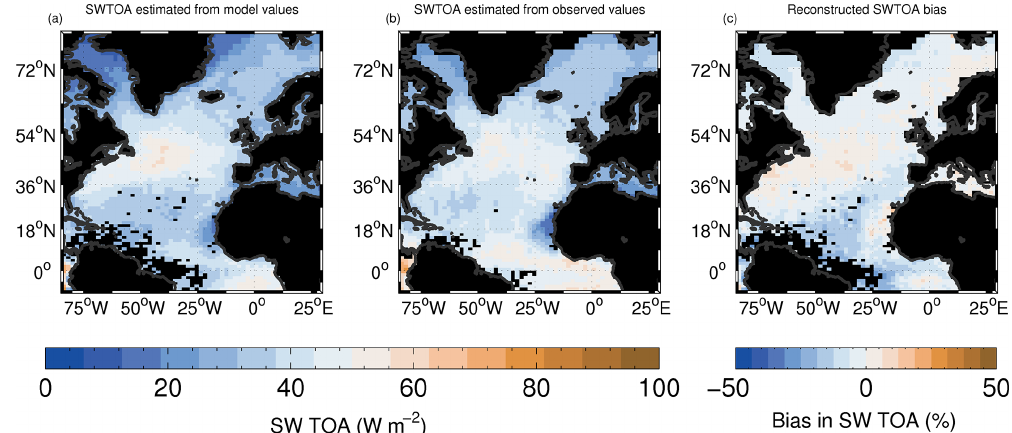
Figure 9. Estimates of the time-mean SW TOA flux ( a, b ; Wm − 2 ); (a) calculated using the time-mean modelled cloud properties (for comparison with Fig. 8a); (b) calculated using the time-mean observed cloud properties (for comparison with Fig. 8b). Panel (c) shows the sum of the estimated contributions from the individual cloud property biases (see Fig. 10) expressed as a percentage of the observed CERES SW TOA flux (for comparison with Fig.